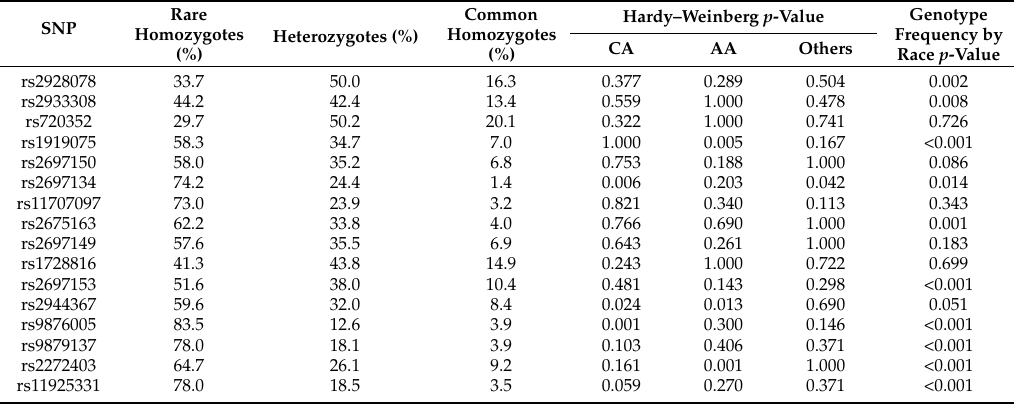
Table 2. List of SNPs with their genotype frequency, and p -values of testing for Hardy–Weinberg equilibrium by